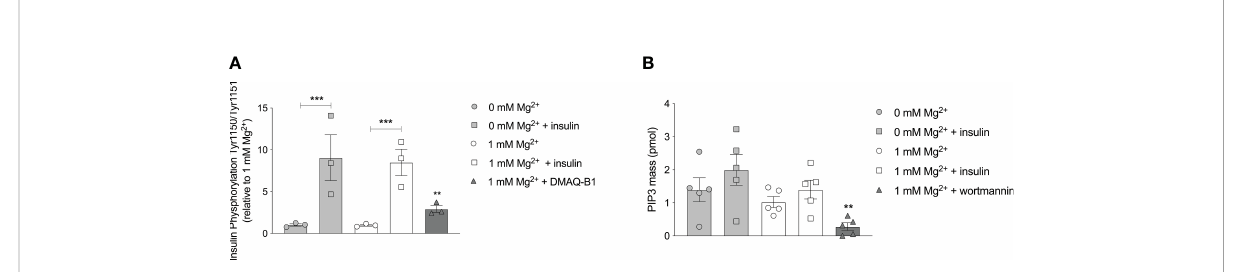
FIGURE 4 Effect of Mg 2+ on the auto phosphorylation of the IR at residue Tyr1150/1151 and PI3K kinase regulatory subunits that phosphorylate PIP2 to PIP3. (A) The phosphorylation of Tyr 1150/115 in 3T3-L1 adipocytes incubated with 0 or 1 mmol/L Mg 2+ . DMAQ-B1 is used as positive control to mimic IR phosphorylation (n=3). (B) PIP3 mass in 3T3-L1 adipocytes incubated with 1 or 0 mmol/L Mg 2+ . Wortmannin is used as positive control to inhibit PI3K enzyme activity (n=5). Legend: circle is without insulin, square is with insulin, grey color is 0 mmol/L Mg 2+ , white color is 1 mmol/L Mg 2+ and rectangles are positive controls. Data are shown as mean ± S.E.M. Statistically analyzed with Two-Way ANOVA. Positive controls are analyzed with Student t-test, compared to 1 mmol/L Mg 2+ condition. **p<0.01; ***p< 0.001. Mg 2+ , magnesium; PIP3, phosphatidylinositol-3,4,5-trisphosphate; DMAQ-B1, demethylasterriquinone